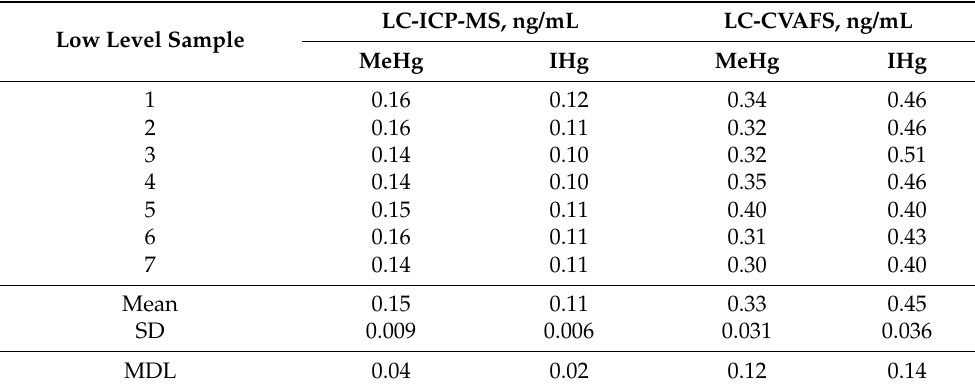
Table 2. Method detection limit (MDL)